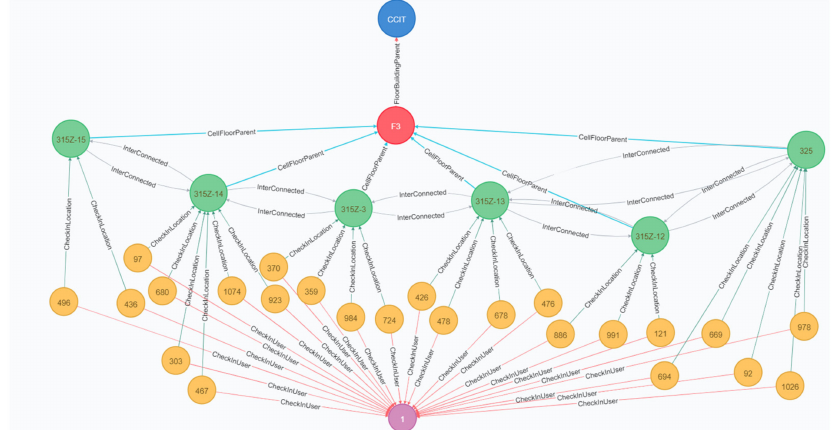
Figure A4. An example of user trajectory modelled by the proposed graph-based semantic indoor trajectory in a real-world experiment using Neo4j graph database for user a single user (i.e., user 1). Nodes are illustrated as circles with different colors: Blue for building, red for floor, green for cells, yellow for trajectory (the number shows the duration of time in seconds for each check-in), and purple for user nodes.